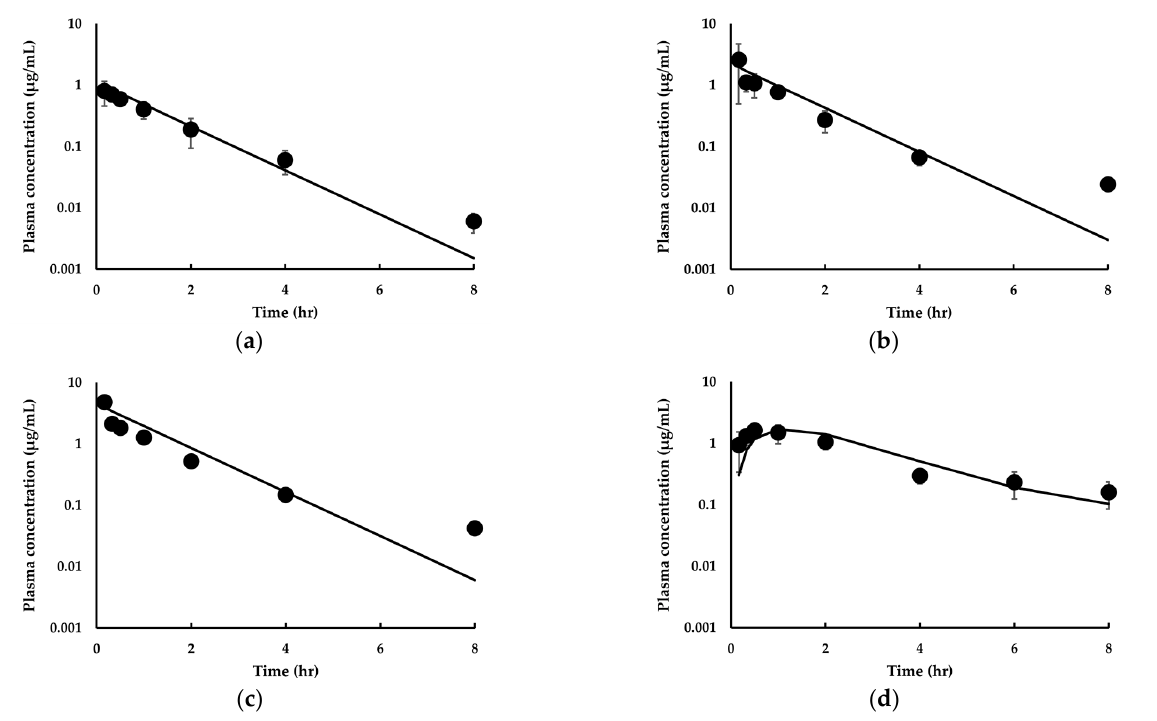
Figure 3. Observed and predicted time-concentration profiles for IDP-73152 following ( a ) 2.5 mg/kg, ( b ) 5 mg/kg, ( c ) 10 mg/kg intravenous, and ( d ) 20 mg/kg oral administration in rats. Solid lines represent predicted data. Closed circles (•) represent observed data. Observed data means ± SD ( n = 3 rats for intravenous administration study, n = 6 rats for oral administration study). Table 3. Observed and predicted PK parameters of IDP-73152 in rats.